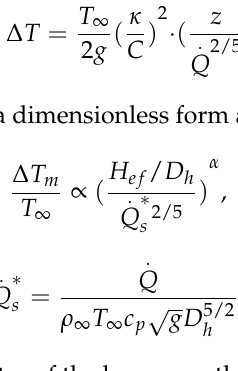
Table 2. Empirical constants in Equation (7).